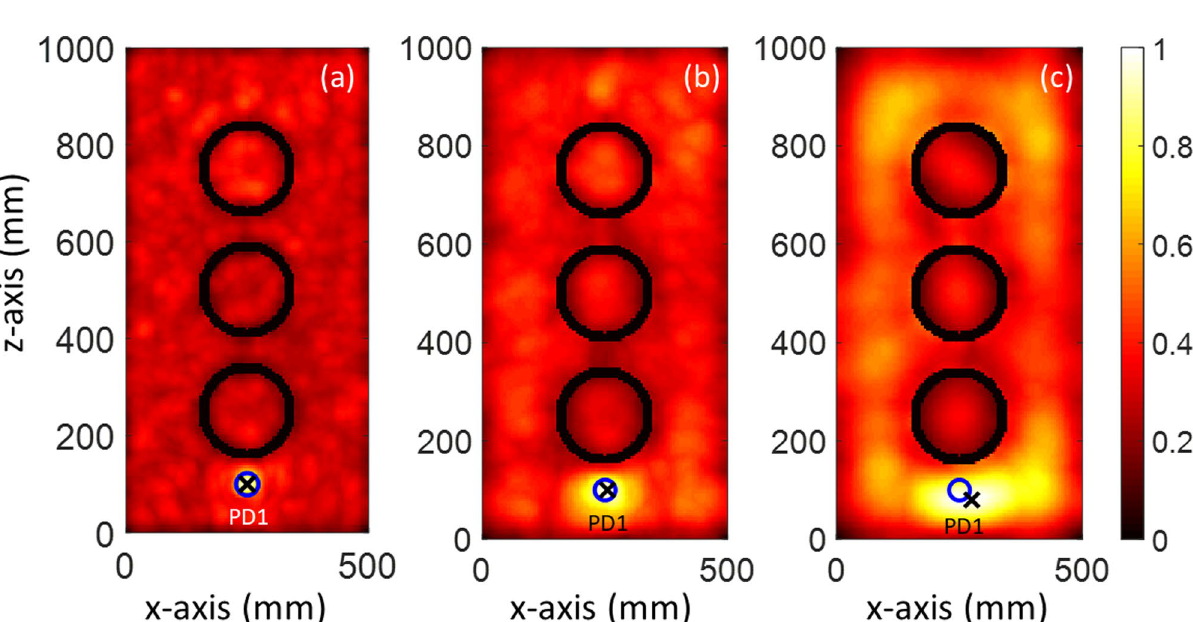
Figure 5. The Distribution of the normalized maximum y-component of the electric field intensity in the x-z cut plane (CS #1). The blue circle and black cross show the actual and estimated location of the PD1 source, respectively. The bandwidth of the PD1 source is ( a ) 3 GHz, ( b ) 2 GHz, and ( c ) 1